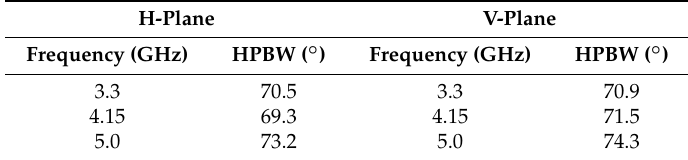
Table 3. Half power beam widths (HPBWs) of the proposed antenna.